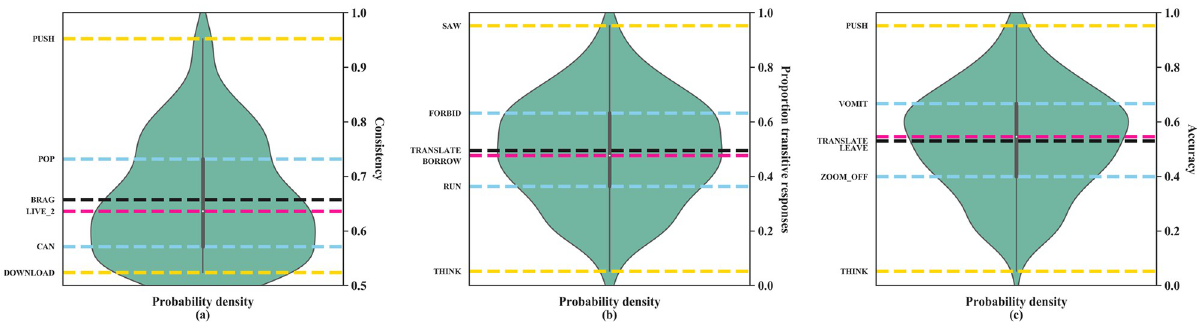
Fig 1. Violin plots showing the distribution of participant responses: Consistency (a), transitivity guesses (b), and accuracy of guesses (c). Width of the violin represents the probability density of the distribution, with wider regions of the plot indicating a higher density of items. In all plots, yellow/ light grey dashed lines represent extreme values (max and min), blue/grey lines the upper (75%) and lower quantiles (25%), the pink/dark grey lines the median, and the black/black lines the mean. Example signs are given next to each line, where examples that have values within 1% of each statistic were randomly selected. (a) shows the consistency of non-signer judgments across the dataset. Signs with values closer to 0.5 were more inconsistently judged, while signs with values closer to 1 were more consistently classed; (b) shows the proportion of transitive responses across the entire dataset. Signs with values below 0.5 (BREAKDOWN, LEAVE) were perceived to be intransitive while signs with values above 0.5 were perceived as transitive (TELL, FORBID, PUSH). Signs nearing or at 0.5 were ambiguously transitive or intransitive. By the width of the plot centered around 0.5, most signs were ambiguous, consistent with the plot in (a). (c) shows the proportion of accurate responses, and indicates that non-signers were largely inaccurate at guessing the transitivity of ASL